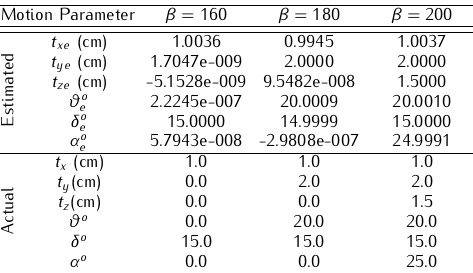
parameters (Combined Motion corrupted